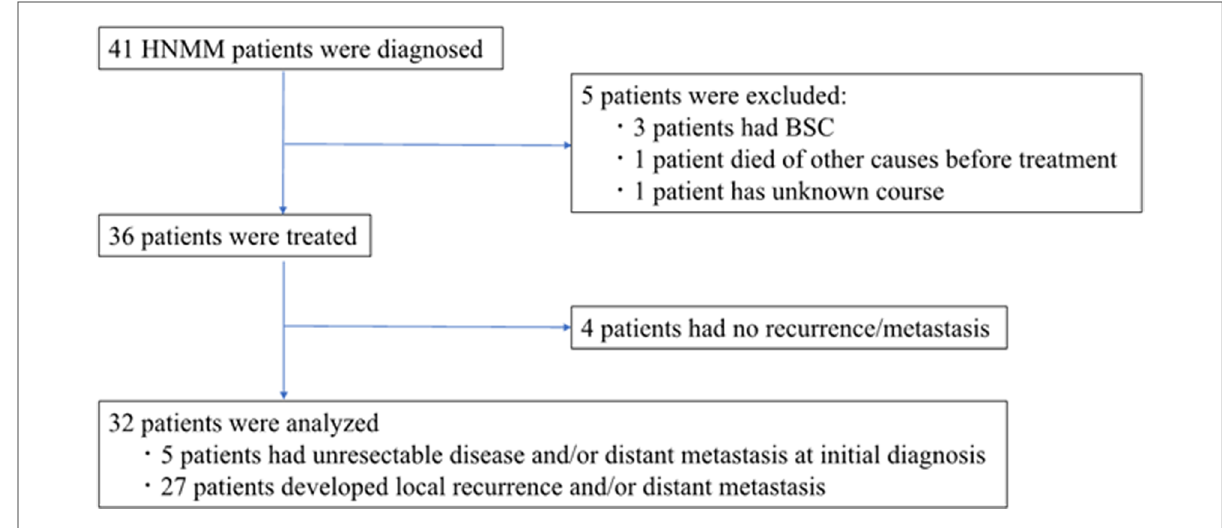
FIGURE 1 Flow diagram of study participants. Of the 36 HNMM patients who received any treatment, we excluded four patients who survived without recurrent/metastatic disease. The remaining 32 patients were analyzed: 5 patients had an unresectable disease and/or distant metastasis at the initial diagnosis, while 27 developed local recurrence and/or distant metastasis after the initial